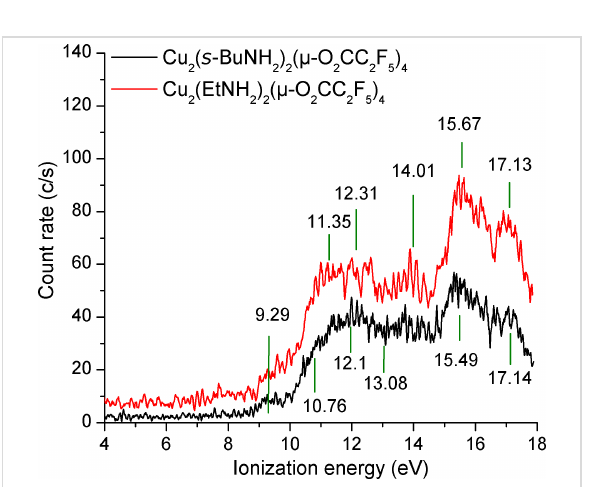
Figure 6: Photoelectron spectra of copper(II) carboxylate complexes [Cu 2 (EtNH 2 ) 2 (µ-O 2 CC 2 F 5 ) 4 ] (red line/upper) and [Cu 2 ( s -BuNH 2 ) 2 (µ- O 2 CC 2 F 5 ) 4 ] (black